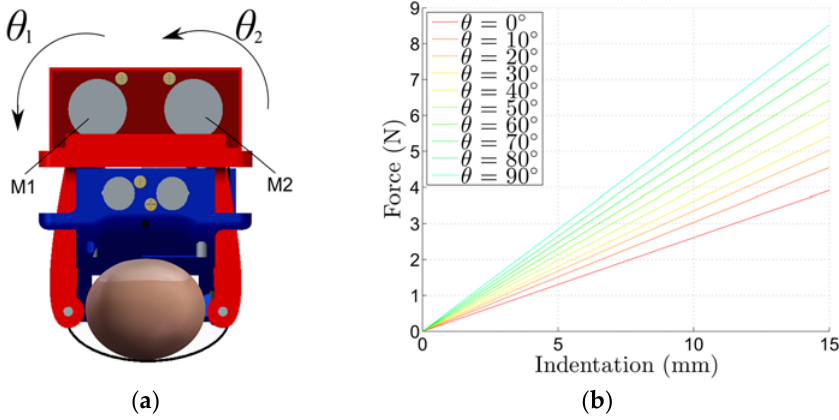
Figure 4. Passive mode: The fabric frame is put in contact with the user’s finger by the camshaft lifting mechanism and servo ‐ motor, inducing a variation of hp (commanded servo motor position) of the frame ( a ); active mode: The user can indent the fabric by flexing the interphalangeal proximal joint of the index finger (IP), while fabric indentation ha can be measured through a contactless infrared sensor ( b ). Reproduced from [18], Copyright 2016, IEEE.